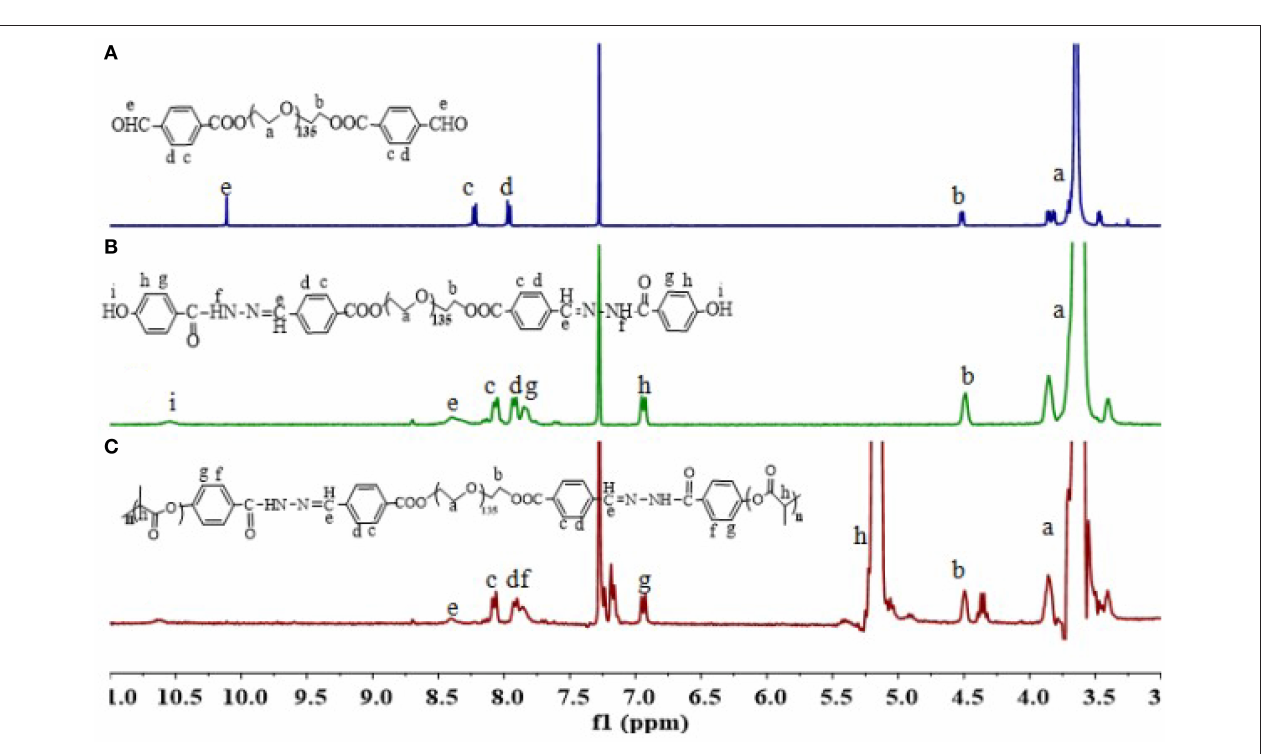
based on 1 H-NMR spectra were consistent with the designed ones. Gel permeation chromatography (GPC) measurements confirmed a unimodal distribution of Mn (16.3, 18.1, and